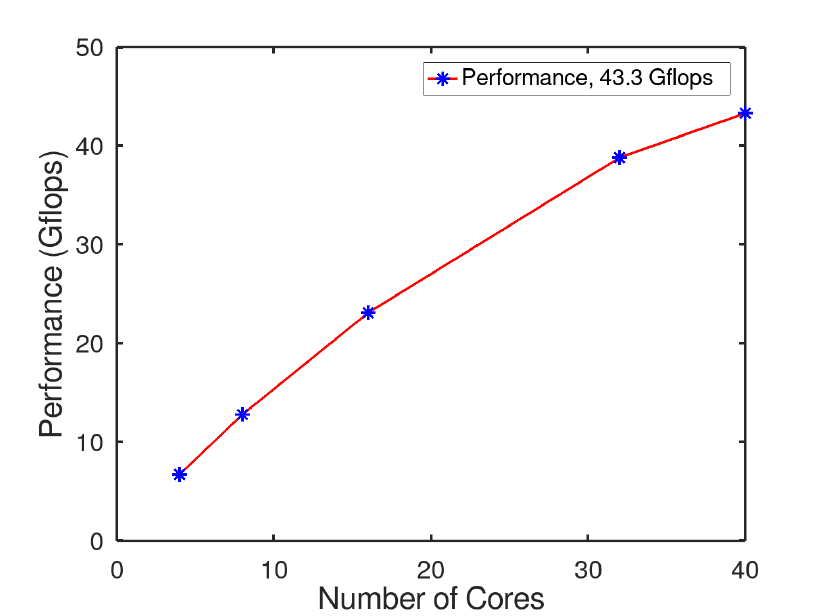
Figure 7. Number of cores vs.